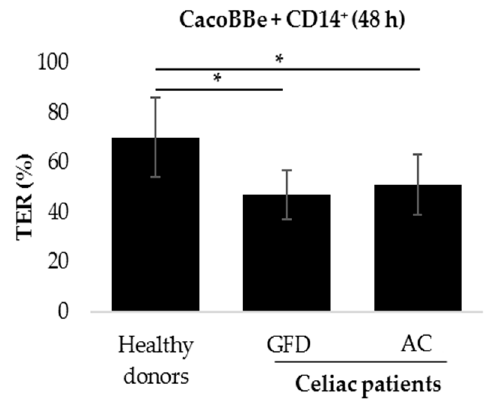
Figure 1. Epithelial barrier function after co-culture of intestinal epithelial cells (IECs) with monocytes derived from celiac disease patients. After peripheral blood mononuclear cell (PBMC) isolation and CD14+ cell-sorting, epithelial cells were co-cultured with monocytes from healthy donors. celiac patients on a gluten-free diet (GFD), or AC (active celiac disease (CeD)) patients. Subsequently, the TER was measured after 48 h of co-culture (% of TER prior to addition of monocytes). Mean of n = 36 (healthy donors), n = 15 (GFD), and n = 20 (AC) individual filters measurements. Monocytes used for these experiments were isolated from n = 8 (healthy donors), n = 4 (GFD) and n = 5 (active CeD). Mann-Whitney U * p < 0.05, comparison between co-cultures with monocytes from healthy donors and CeD patients.